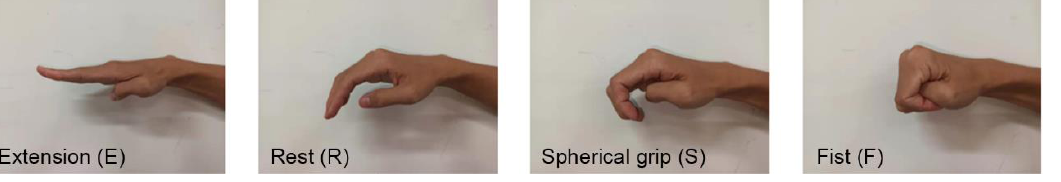
Figure 3. Four hand motions.